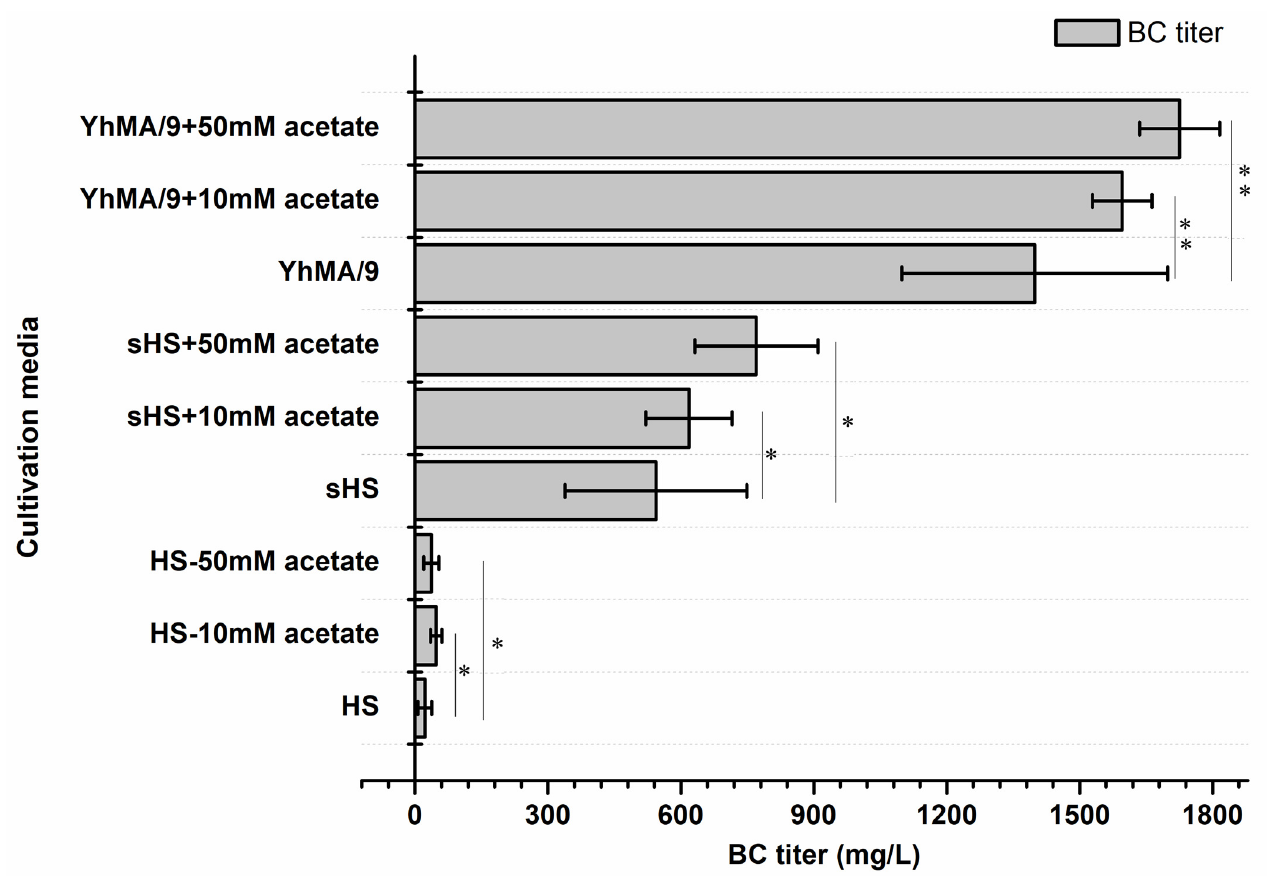
Figure 6. BC production of K. rhaeticus ENS9b cells in control and sample cultivations containing 10 mM and 50 mM acetate in HS, sHS and YhMA/9 media. The presented results are the averaged values (duplicates for control cultivations and triplicates for media with acetate) and the error bars represent the standard deviations. A two sample t -test with equal variances using the log10 transformed values was implemented to compare the control and sample cultivations. Samples with p > 0.05 and p < 0.05 are represented by * and **, respectively.